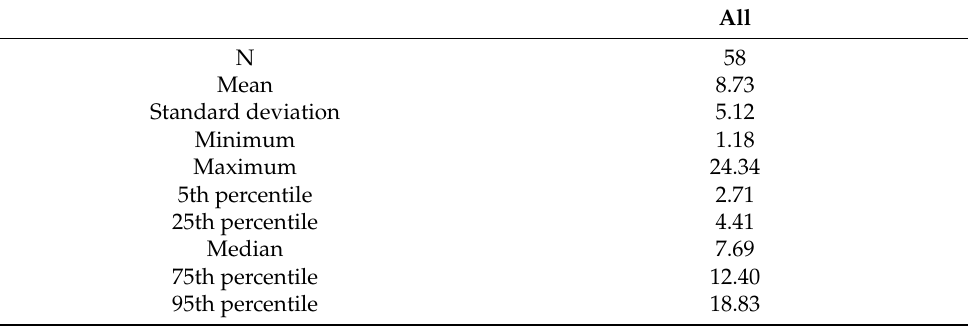
Table 1. Descriptive statistics of the take-over times (in